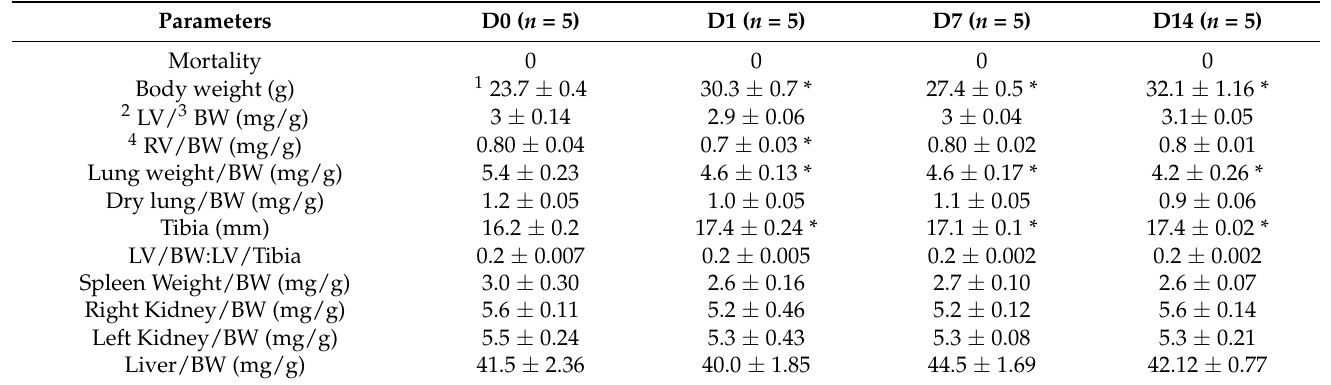
Table 1. Necropsy Parameters in Treated and Control